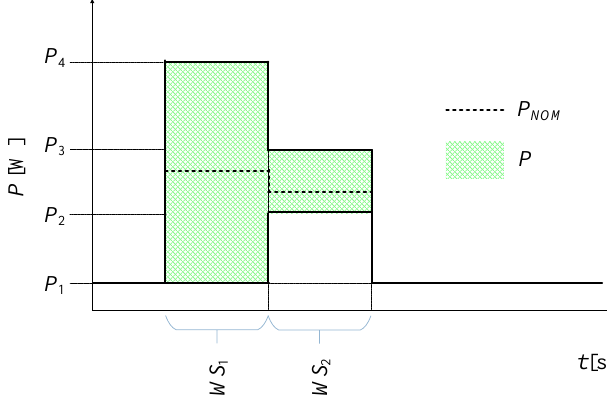
Figure 4. Graphical presentation of parameters that define